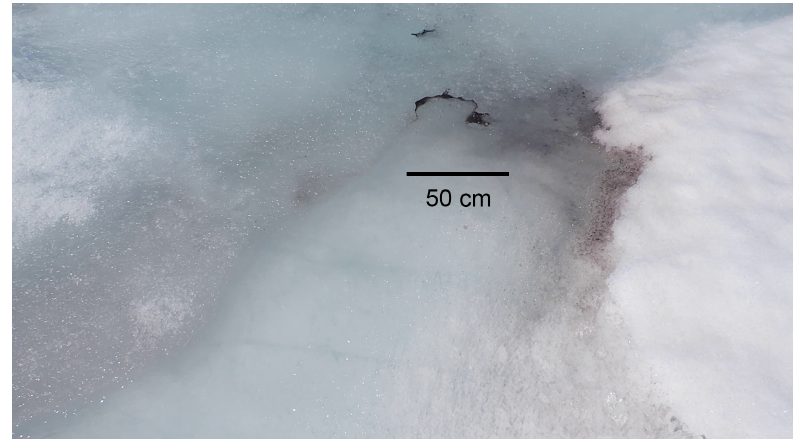
Figure D2. Oblique photograph illustrating locally high concentrations of flushed impurities including glacier algae at a change in gradient of an ephemeral surface stream incised through stagnant snowpack, on 26 June 2017, with approximate scale bar. Photograph taken within ∼ 100m of UAS survey